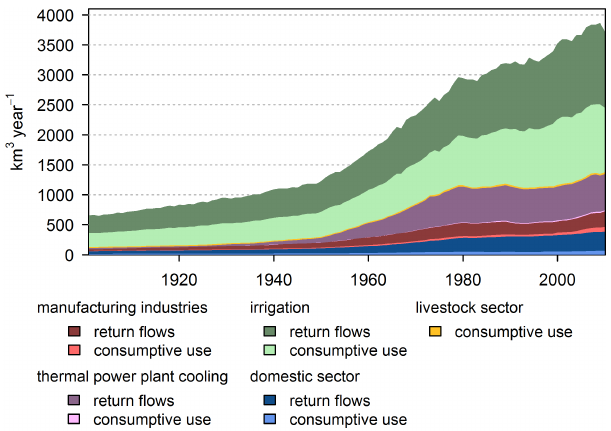
Figure 3. Development of water abstractions (sum of return flows and consumptive use) and water consumption (the amount of water that is evapotranspired or incorporated in products, light colours) of the five water use sectors considered in WaterGAP for 1901–2010. Values for irrigation (modelled with 70% of demand in grid cells with groundwater depletion) are averaged across the five climate forcings; other sectors are modelled independently of climate forc- ing and taken from Flörke et al.